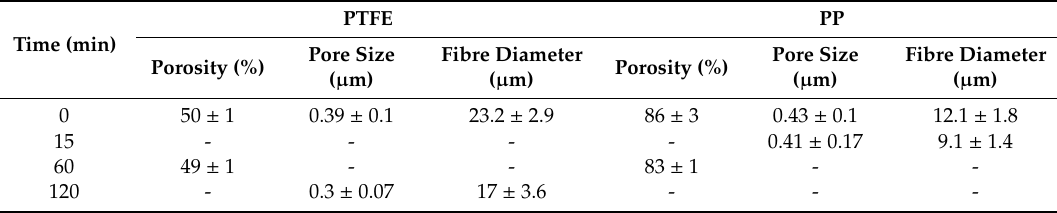
Table 4. PTFE and PP membrane morphology characteristics and